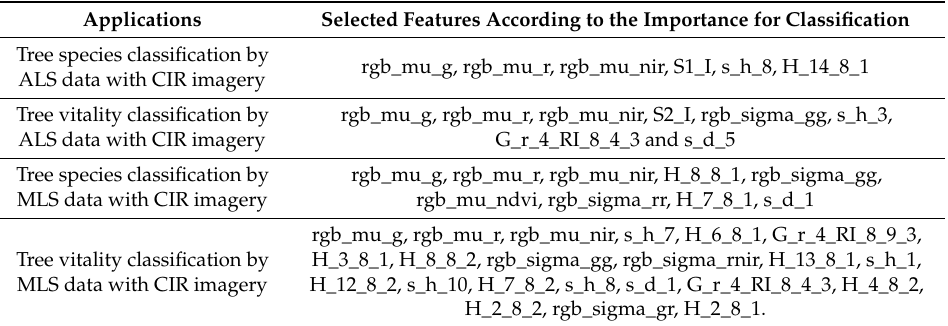
Table 2. Selected features for different classification applications by forward selection method.